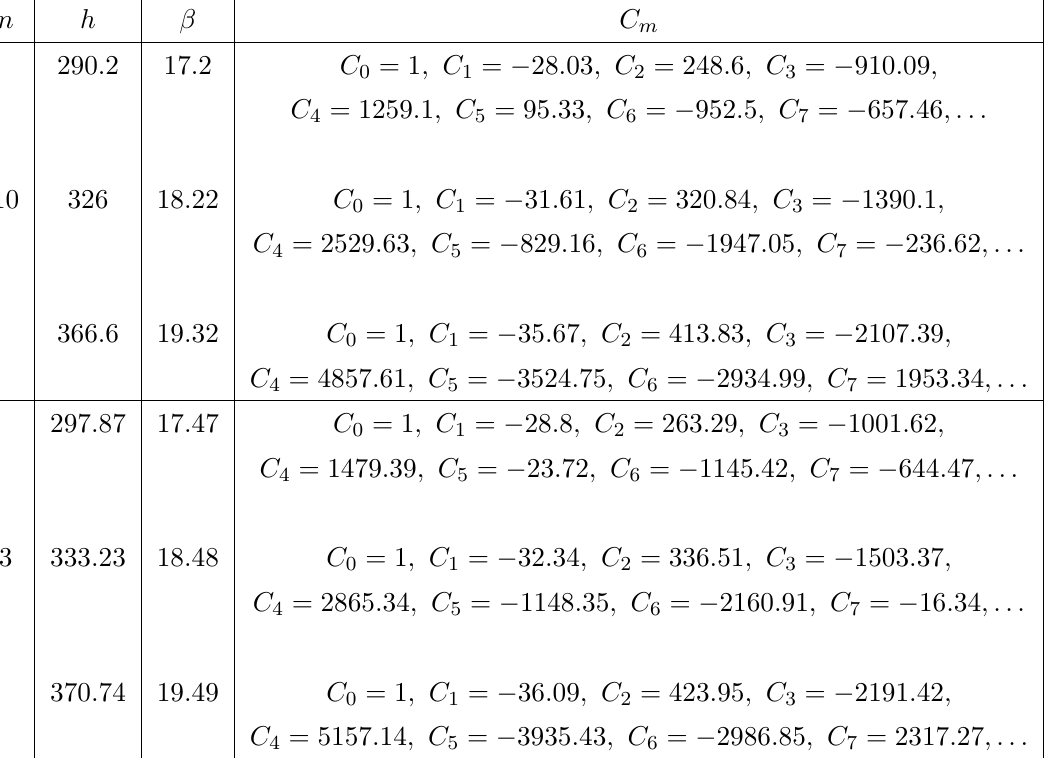
Table 2. Values of the coe(cid:14)cients C m (eq. (3.25)) for di(cid:11)erent